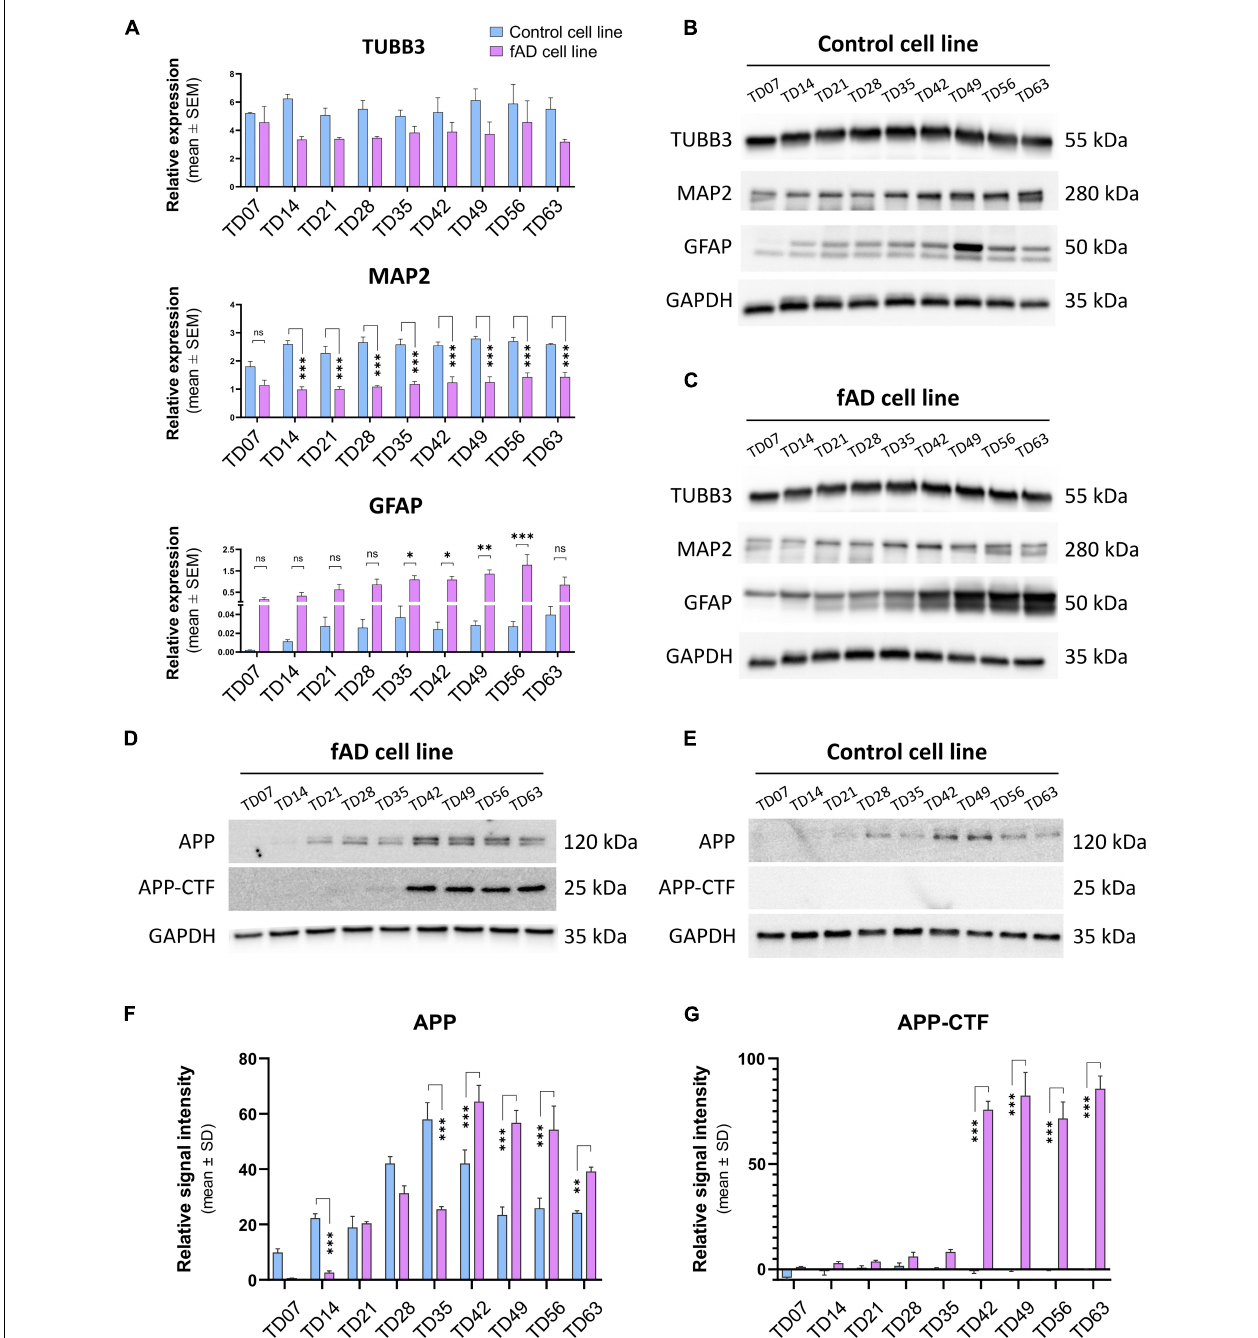
FIGURE 2 | Representative immunostaining of the relevant stages is presenting the basic morphology and expression of main neuronal markers of the cell cultures: Nestin (magenta, or green)—NPC marker; TUBB3 (red) and MAP2 (red) are neuronal markers, and GFAP (green) as an intermediate filament astrocyte marker; nuclei are counterstained with DAPI in all cases (blue). (A) RT-qPCR detection of main neuronal (TUBB3 and MAP2) and astrocytic (GFAP) markers on neuronal cultures from TD7 until TD63 stage at weekly intervals. Bars represent the relative expression data (mean ± SEM). Data were normalized with the positive control GAPDH. ∗ p < 0.05; ∗∗ p < 0.01. The presented analyses are representative of three independent experiments. (B,C) Representative Western blot results show the expression of TUBB3, MAP2, and GFAP in the neuronal cultures. 10 µ g of protein per lane was used. (D,E) Representative Western blots confirm the presence of Alzheimer’s disease-related proteins in our culture system. The presence of the C-terminal fragment of APP (APP-CTF) in the fAD cell cultures but not in the control cell line cultures signifies the ongoing Alzheimer’s disease phenotype. Five micrograms of protein per lane was used. As a positive control, GAPDH was used in all Western blots. (F,G) Quantification and comparison of APP and APP-CTF protein expressions in con control and fAD cell lines. Error bars represent the mean ± SD of three measurements. ∗∗∗ p < 0.001.